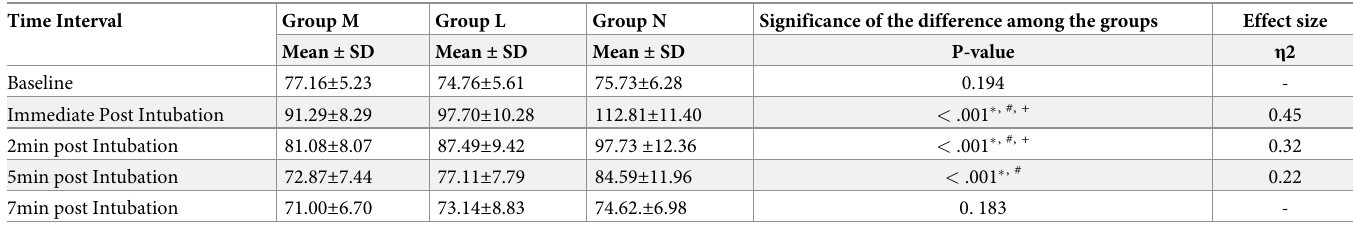
Table 4. Comparison of mean DBP among the groups and between groups at different time intervals in Zewditu Memorial Hospital, Addis Ababa, 2018/2019. Time Interval